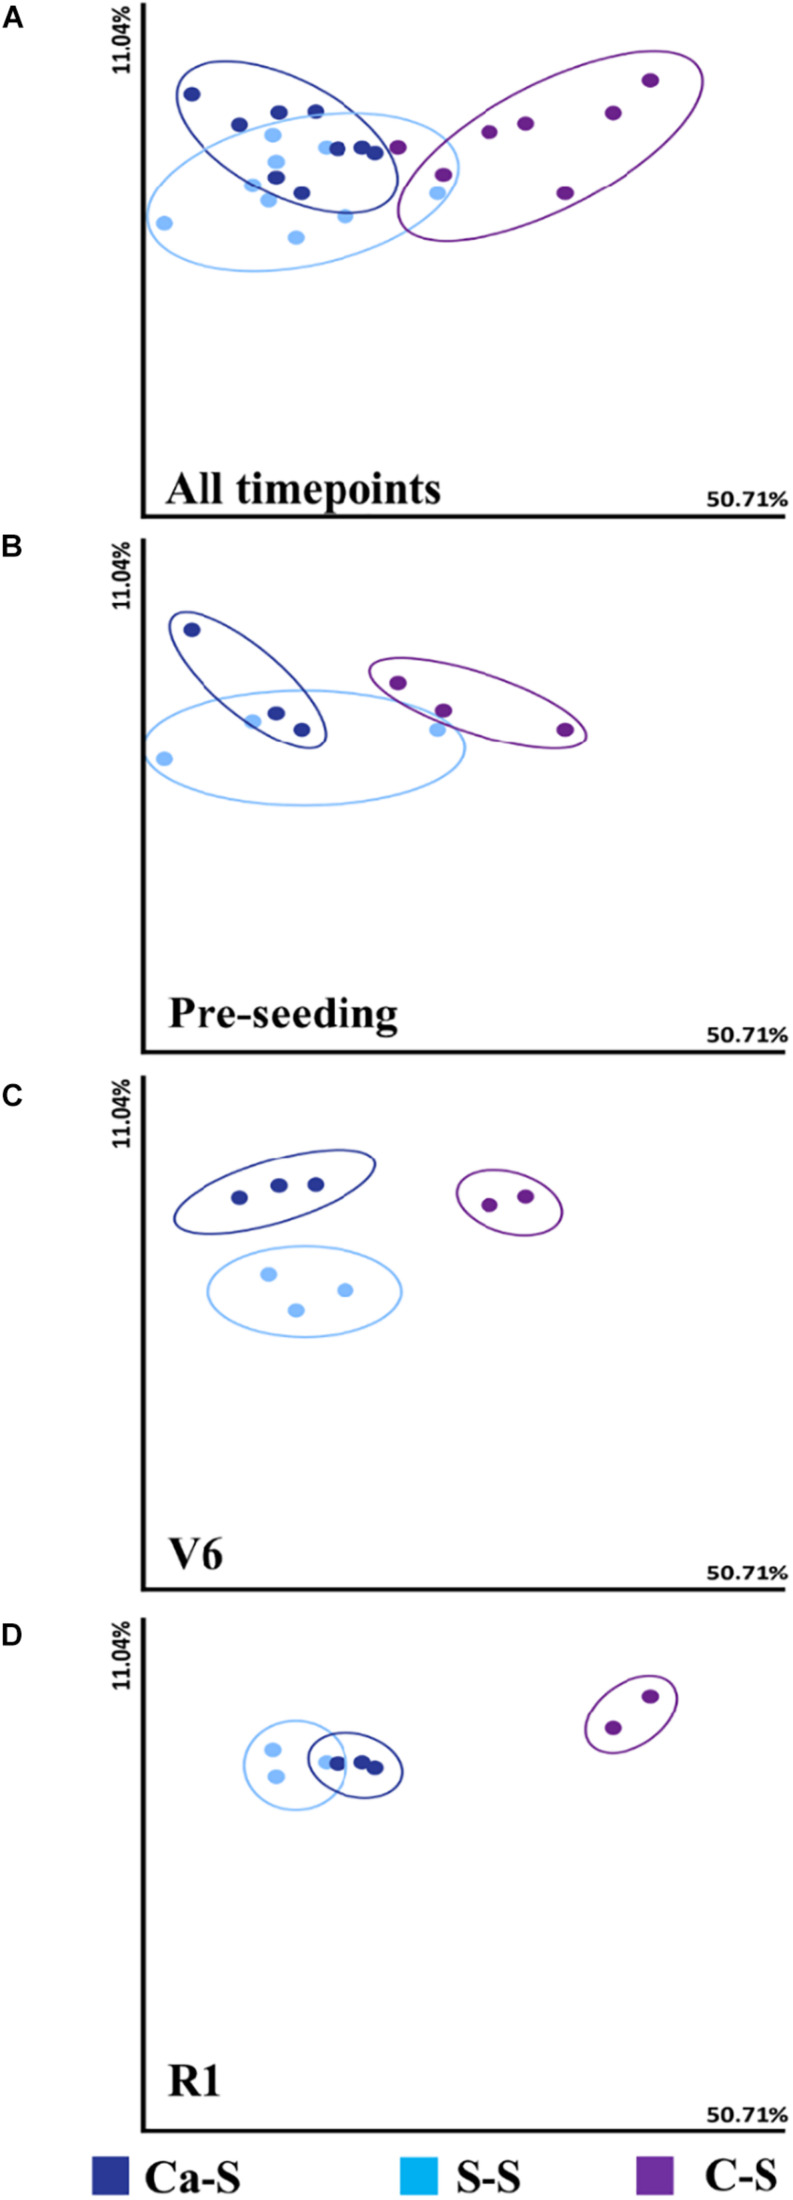
Influence of crop sequence on bacterial species diversity in the bulk soil Principal coordinate analysis (PCoA), represented by the beta diversity metric – Weighted UniFrac, comparing the effect of crop sequence on microbial species diversity among treatments at all time points in the bulk soil. For each axis, the percent of variation is indicated. Dark blue dots, canola-soybean sequence (Ca-S); light blue dots, soybean-soybean sequence (S-S); purple dots, corn-soybean sequence (C-S). Each dot represents the average of three biological replicates and each biological replicate represents five pooled core soil samples. Comparison of cumulative bacterial species diversity for all sequences collect at (A) all time-points (B) pre-seeding (C) V6, and (D) R1 soybean growth stages. Because of similarities in the data, some data points are overlapping.